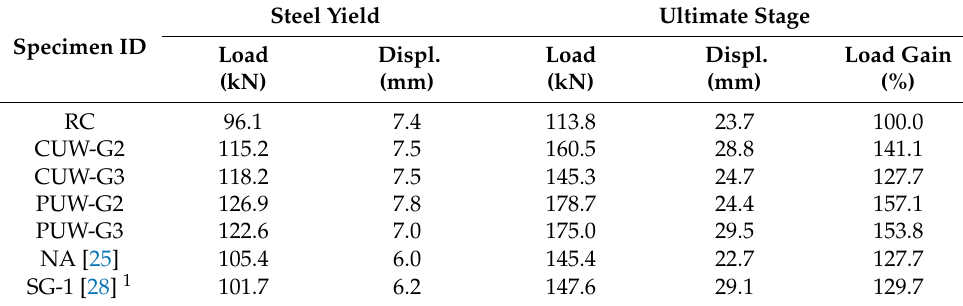
Figure 13. Load-displacement curve of RC slabs repaired with TRC grouting system. Table 8. Results of flexural test for slab specimens.